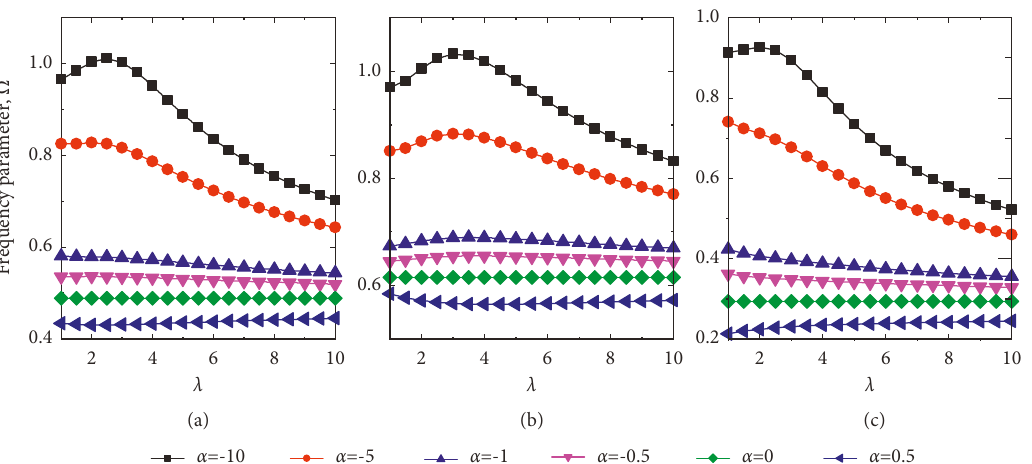
Figure 6: Frequency parameters of laminated composite structures according to the change of thickness variation parameter α and λ , (a) conical shell, (b) cylindrical shell, and (c) annular